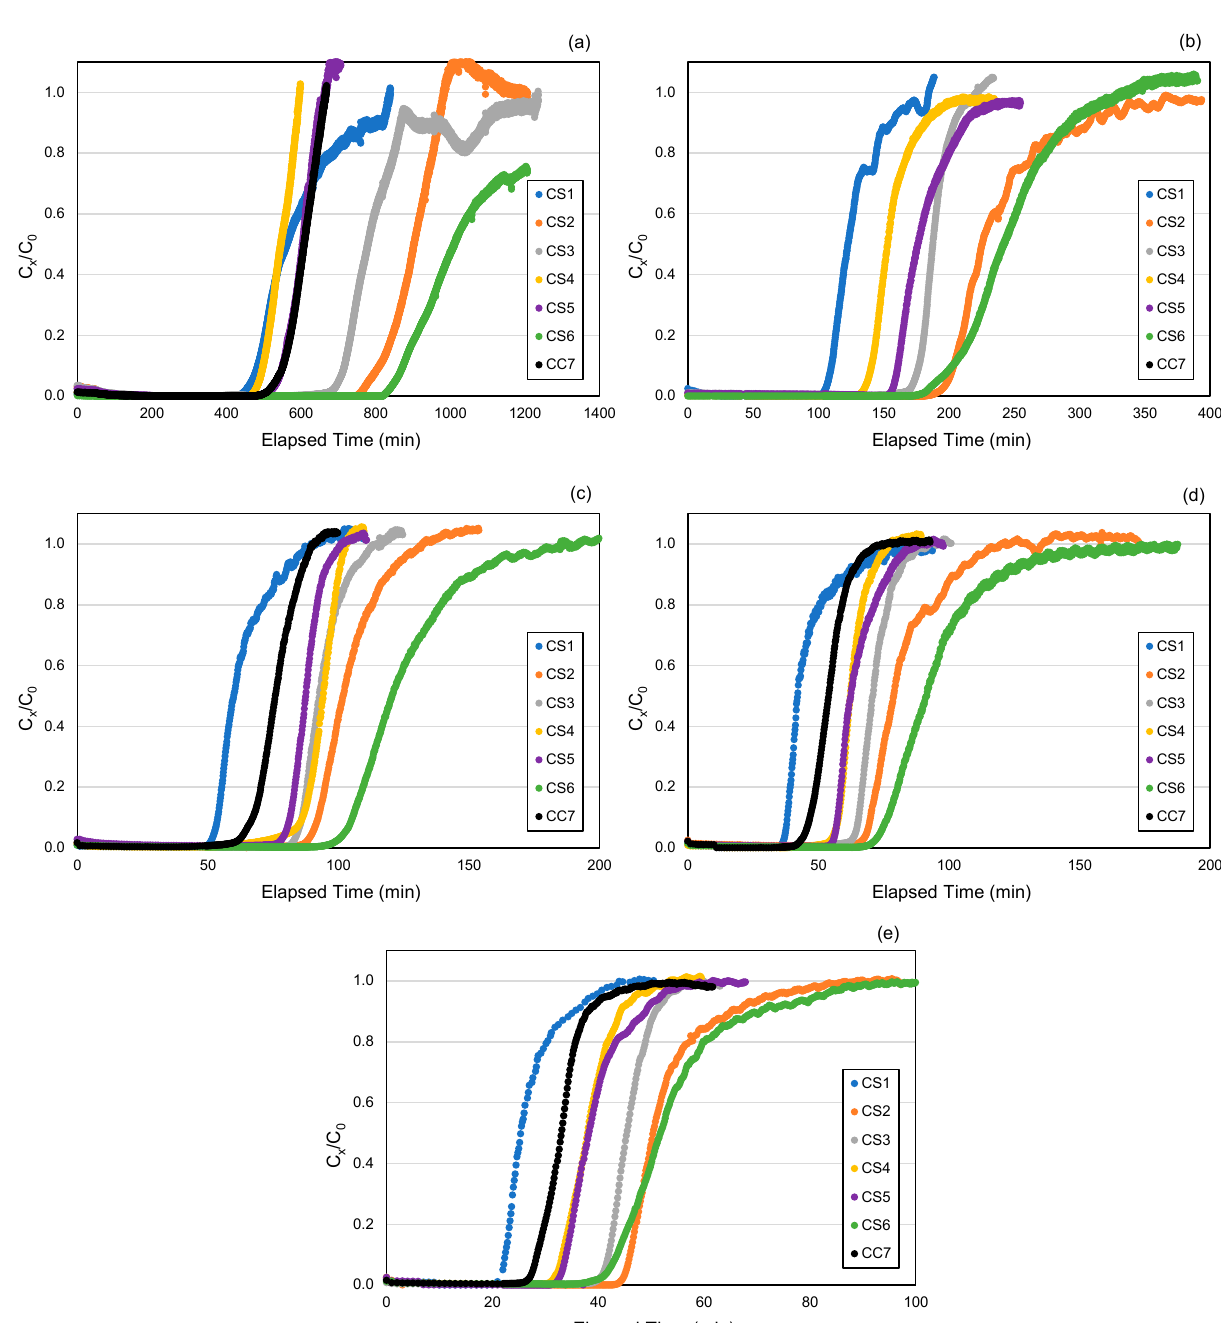
Figure 3. Breakthrough curves by cartridge type at 5 toluene concentrations: ( a ) 20 ppm, ( b ) 100 ppm, ( c ) 200 ppm, ( d ) 300 ppm, ( e ) 500 ppm. Cartridge type (ACF composition): CS1 (100% AF1); CS2 (100% AF2); CS3 (100% AF3); CS4 (100% AF4); CS5 (100% AF5); CS6 (100% AF6); CC7 (71% AF1/29% AC1).